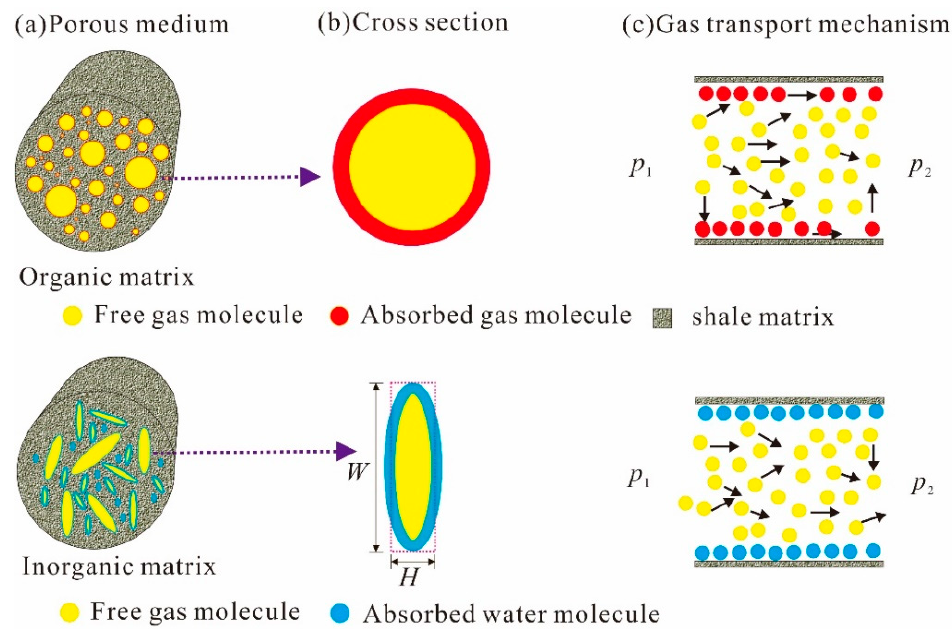
Figure 1. The conceptual diagram of gas storage and transport mechanisms in diverse matrix.